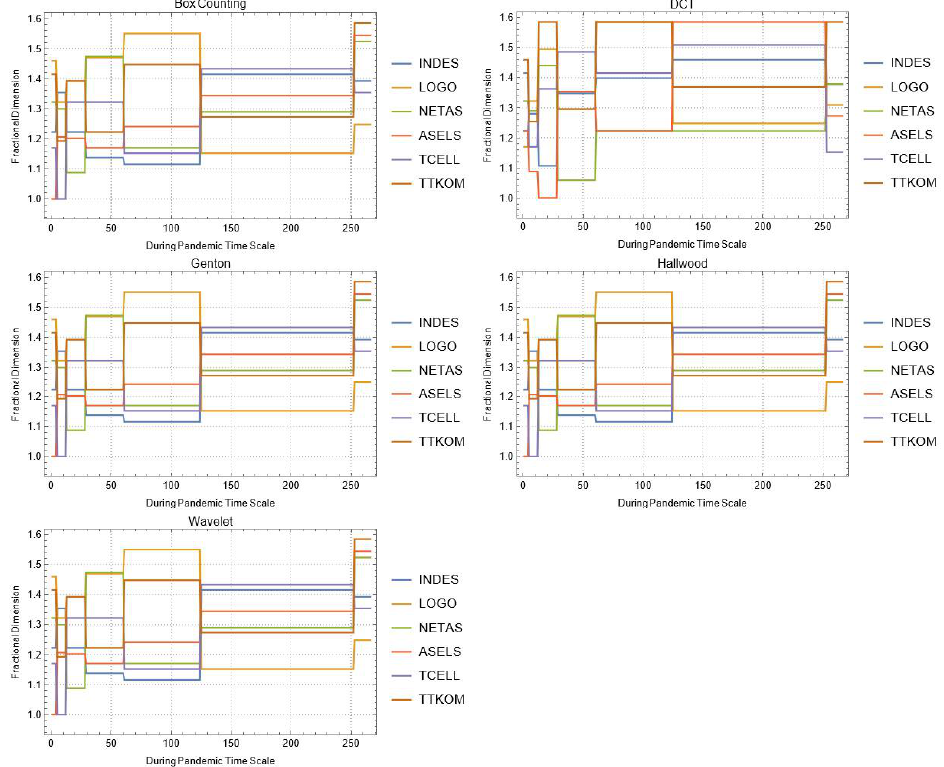
Figure A12. Daily changes of fractal dimensions during the pandemic (technology).